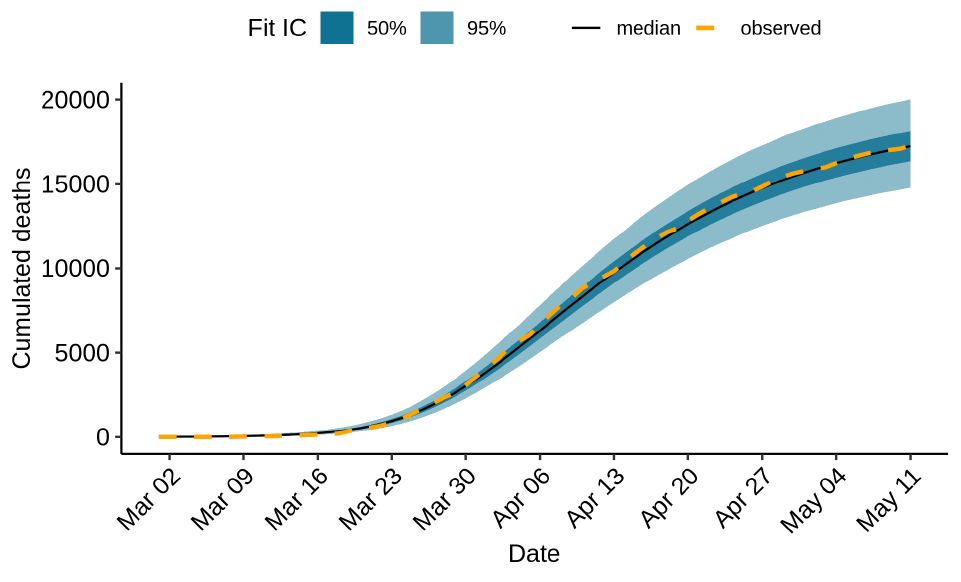
Figure 4 – Cumulated mortality over time, fitting data up to May 11.